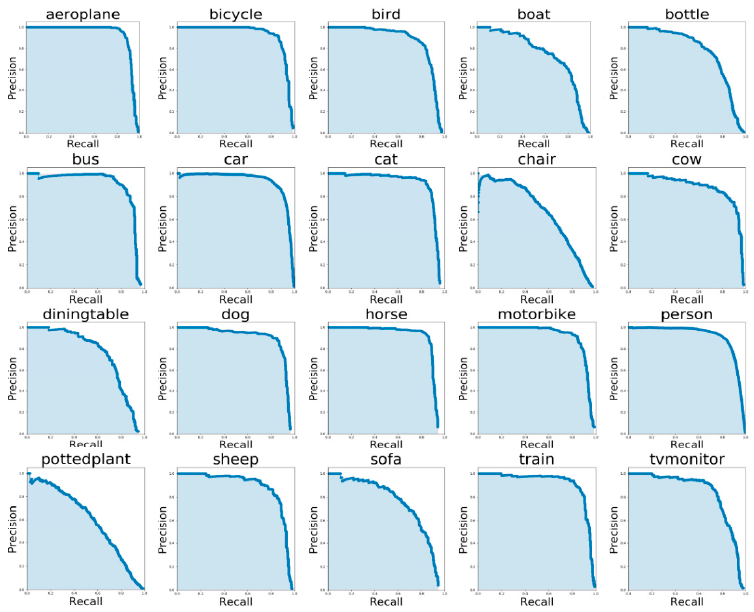
Figure 4. P–R maps for the PASCAL VOC 2007 test dataset.